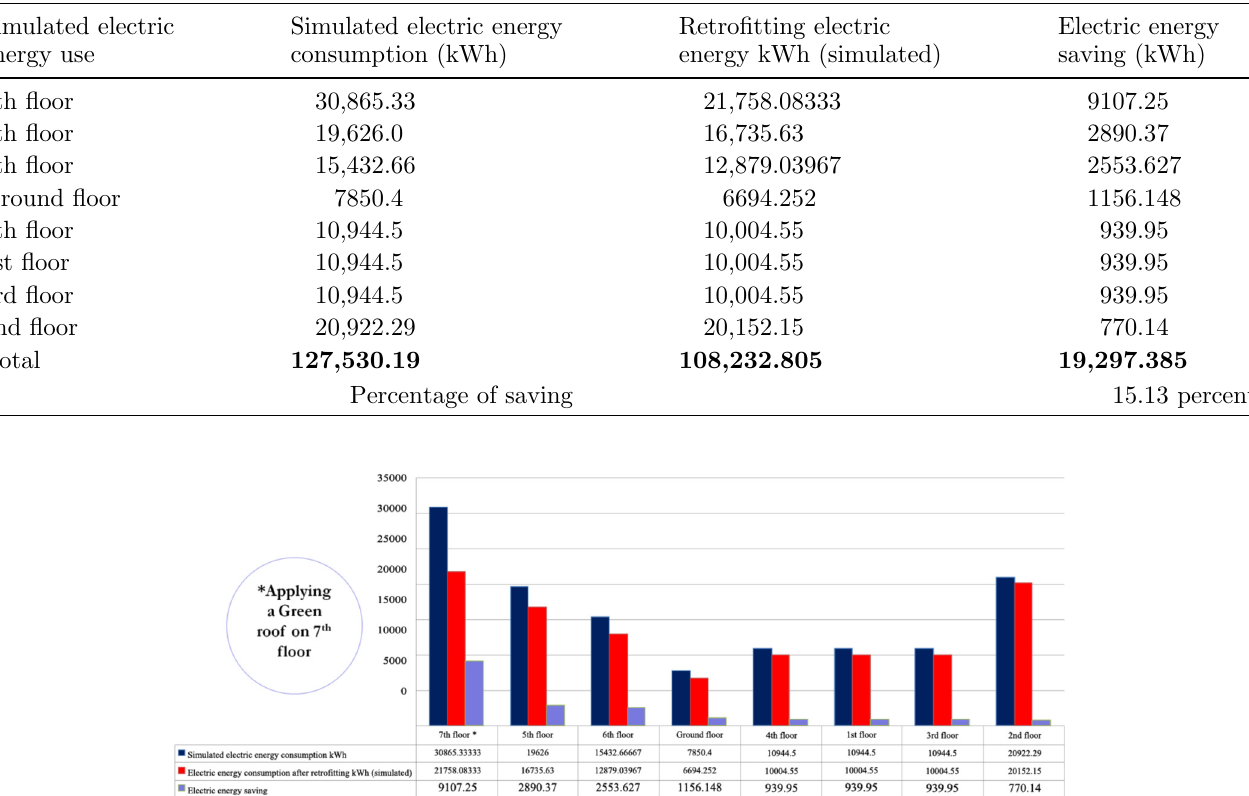
Table 3. Comparison of simulated, retro fi tting, and energy savings – all fl oors.